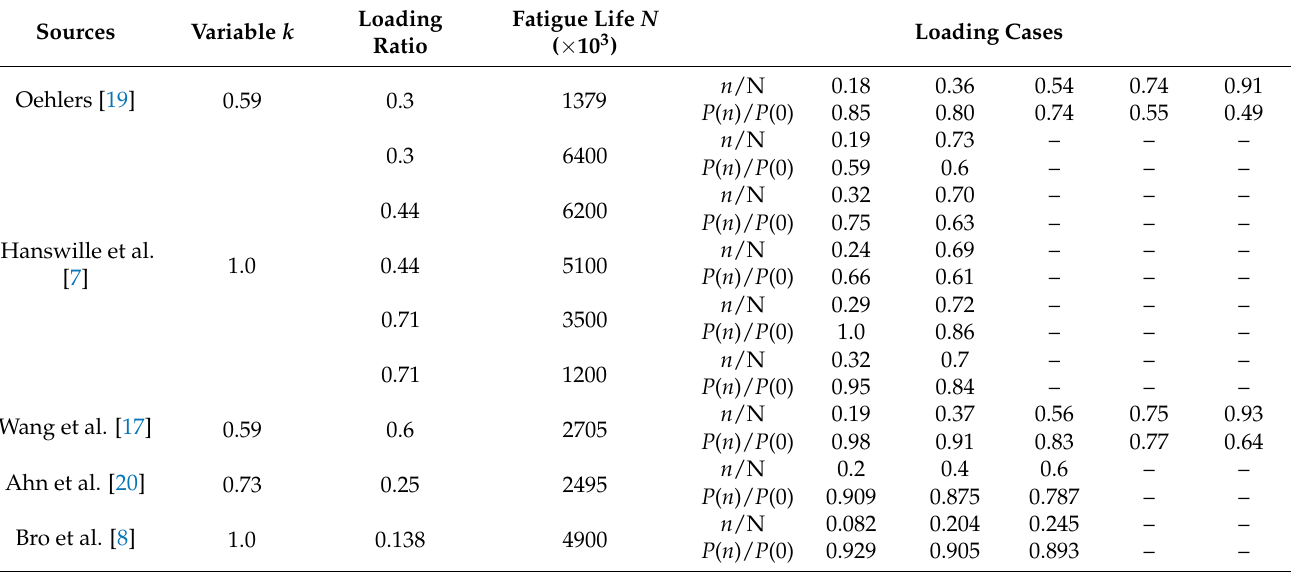
Table 1. Summarization of experimental